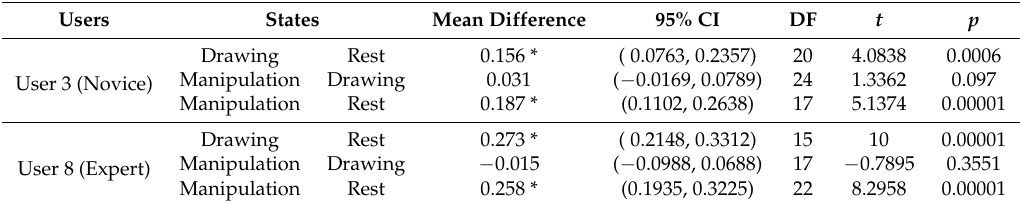
Table 2. Statistical validation of clustering coefficients for typical novice and expert users.